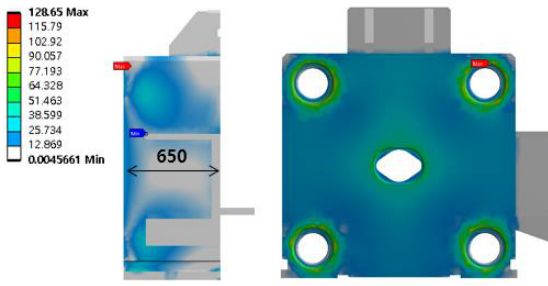
Figure 7. Von-mises stress of main cylinder housing.